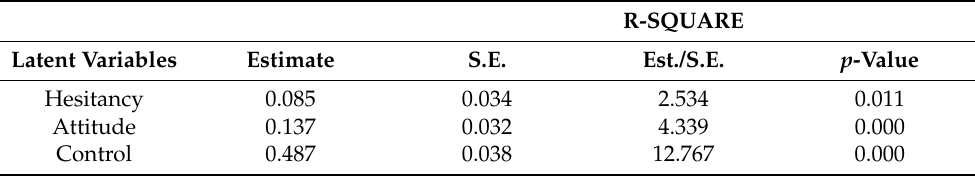
Table 2. R-square of latent independent